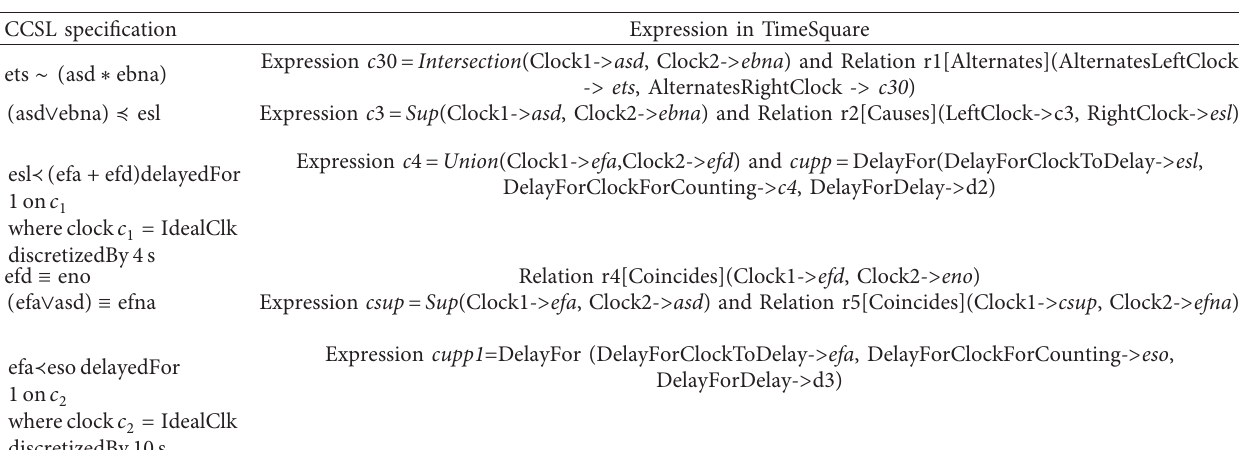
Figure 10: One partial simulation trace for the autonomous overtaking system. Table 4: CCSL specification and expression in